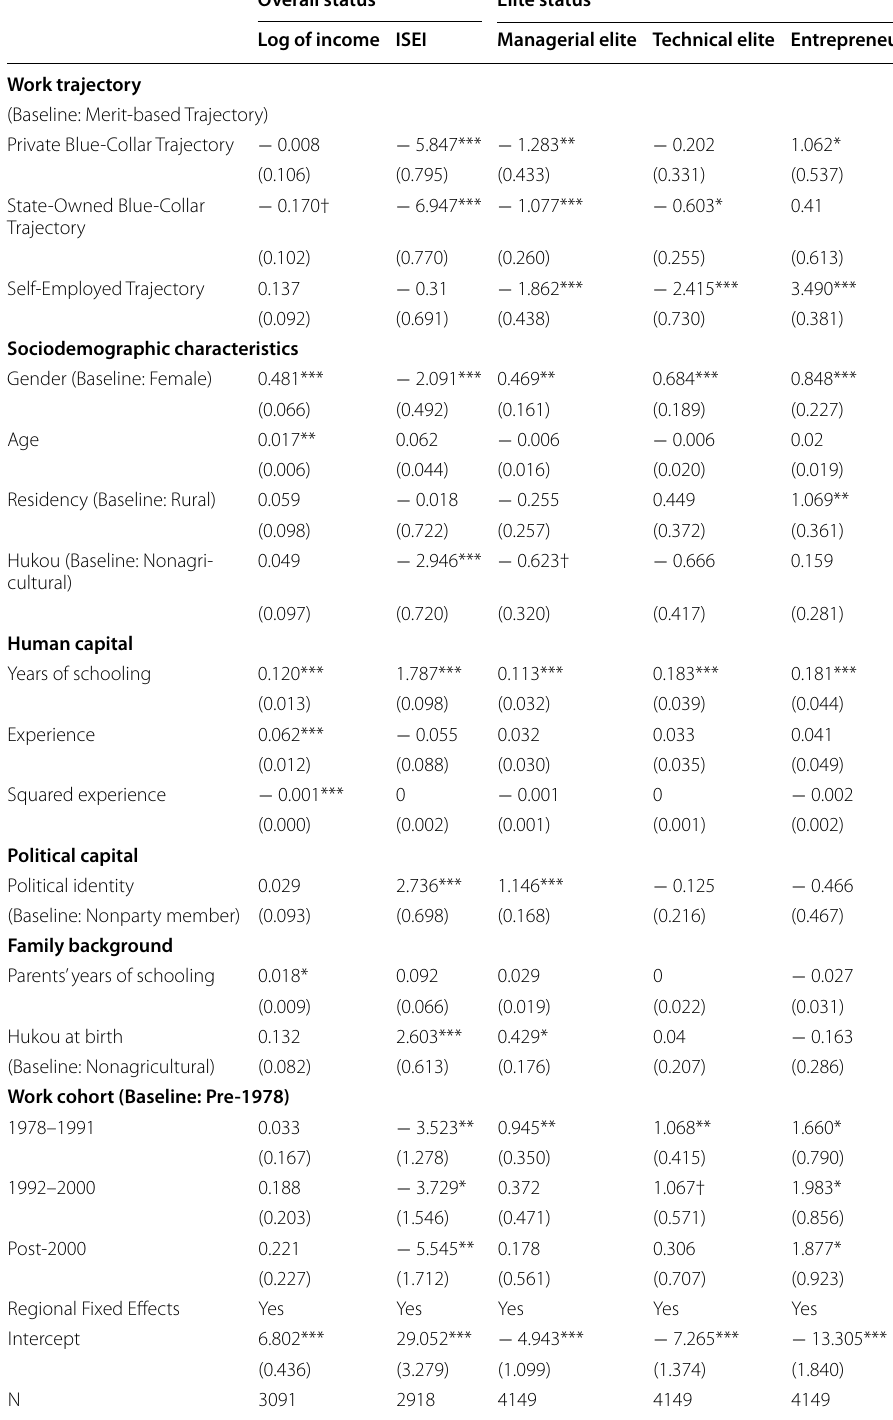
Table 2 Effect of different work trajectories on status